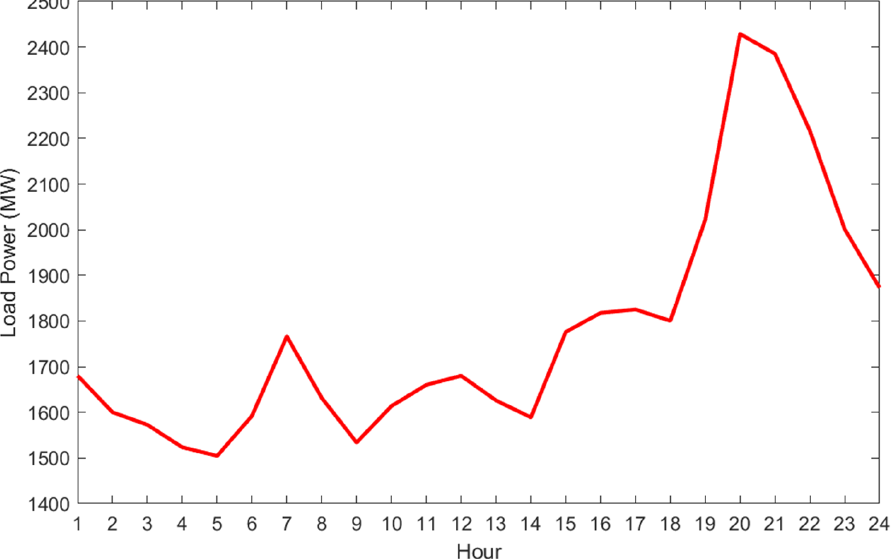
Energies 2023 , 16 , x FOR PEER REVIEW Figure 4. The daily load curve of the test system. Figure 4. The daily load curve of the test system.